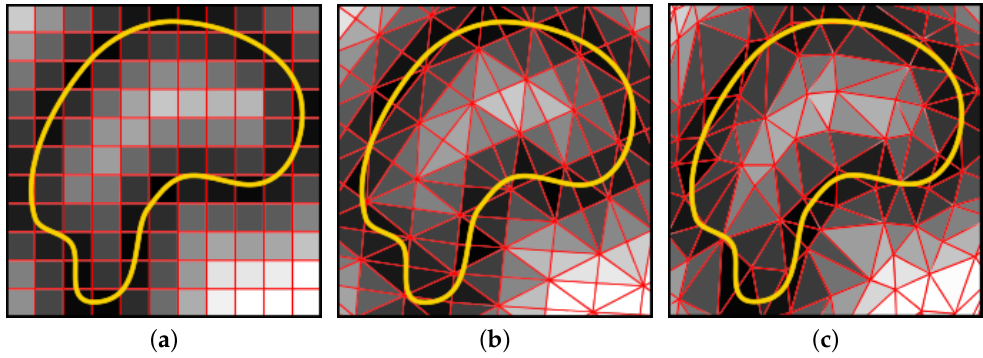
Figure 1. DT applied to different types of grids ( a ) regular image-based grid, ( b ) semi-regular Disdyakis Triacontahedron DGGS grid, ( c ) irregular general mesh. In this visualization, darker cells are closer to the feature and brighter cells are farther to the